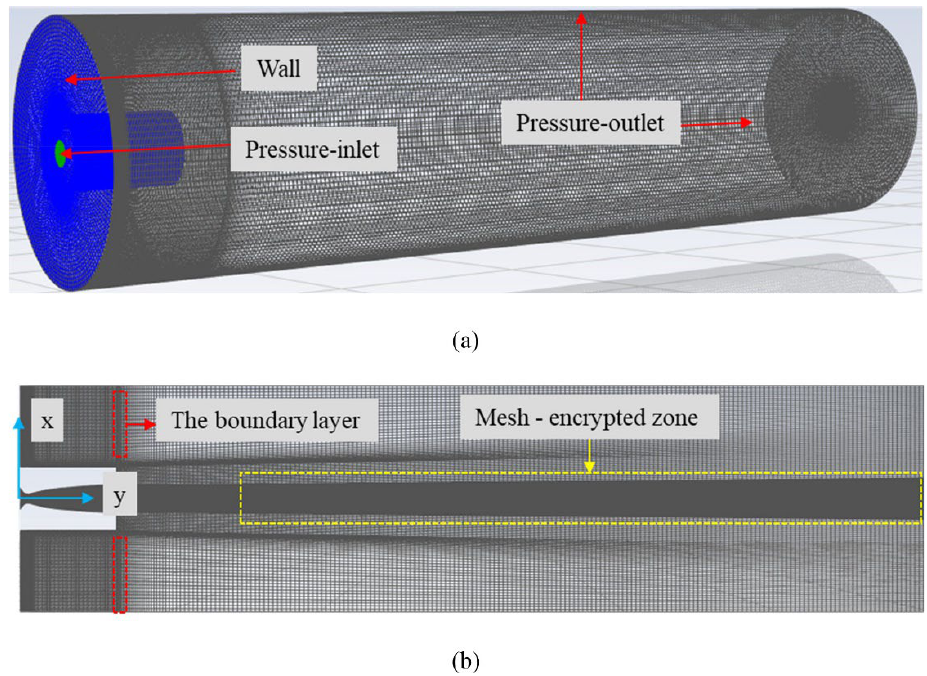
Figure 12. Structural meshes: ( a ) Three-dimensional view of the computational domain and ( b ) axial profiles [129].